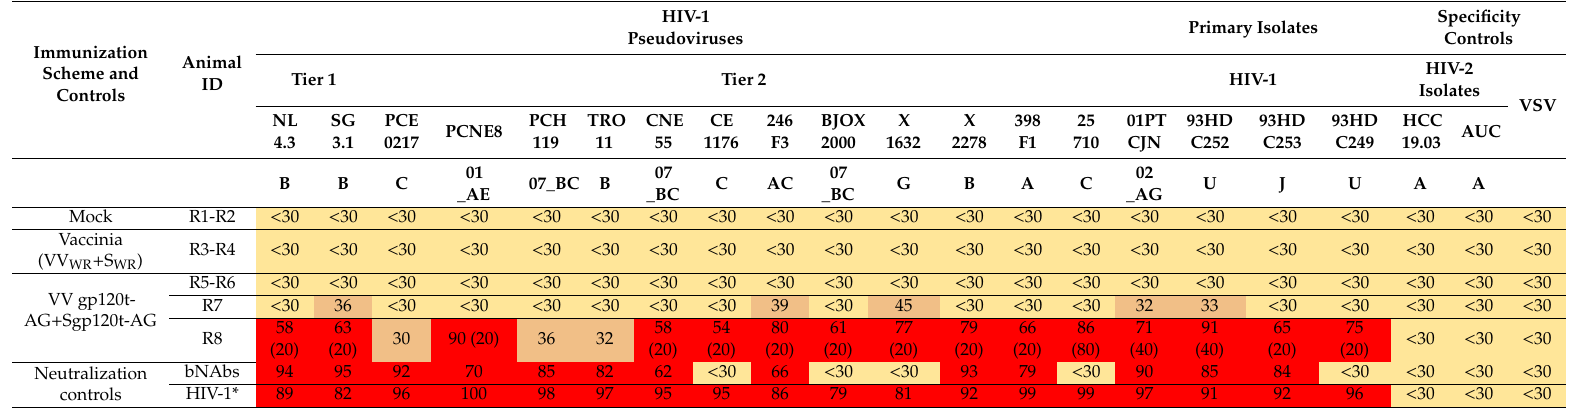
Table 6. Neutralizing activity of rabbit sera immunized with CRF01_AG-derived immunogens